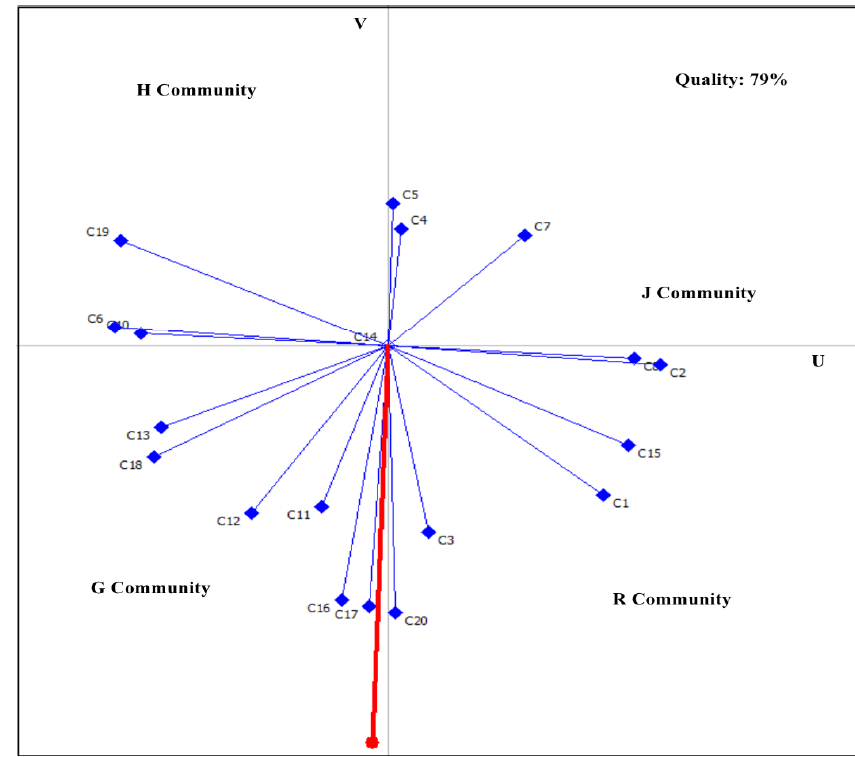
Figure 7. Graphical analysis for interactive aid with U-V coordinate systems.